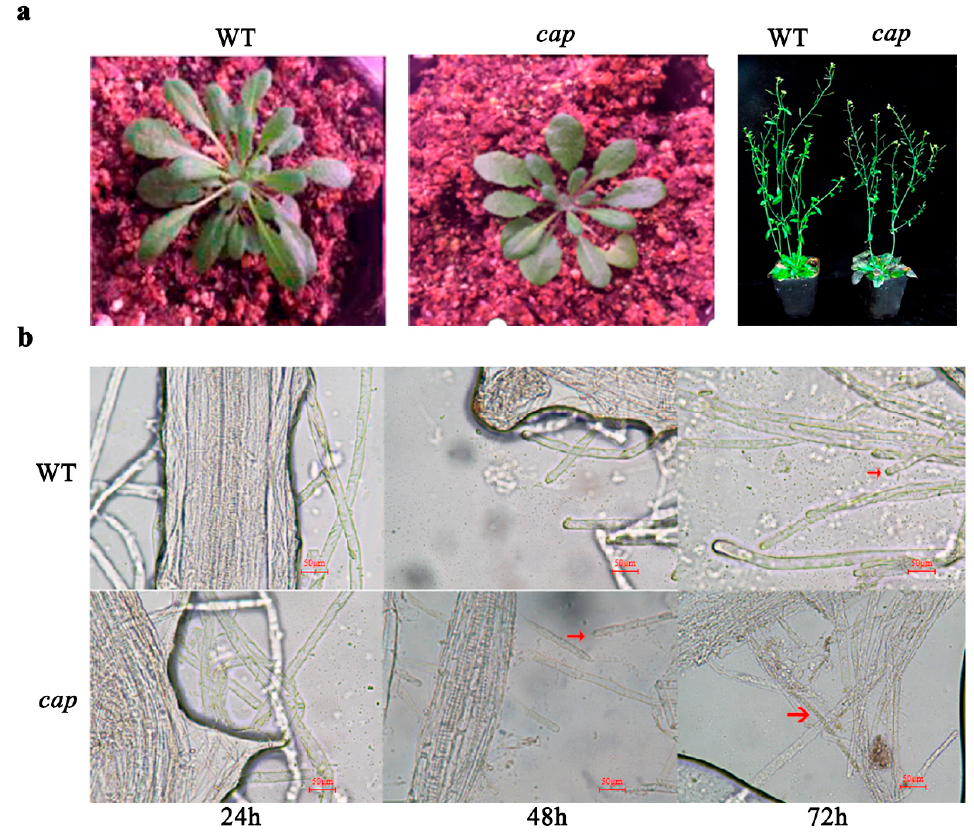
Figure 3. Phenotypic comparison and resistance identification for mutant CAP and WT. ( a ). Pheno-